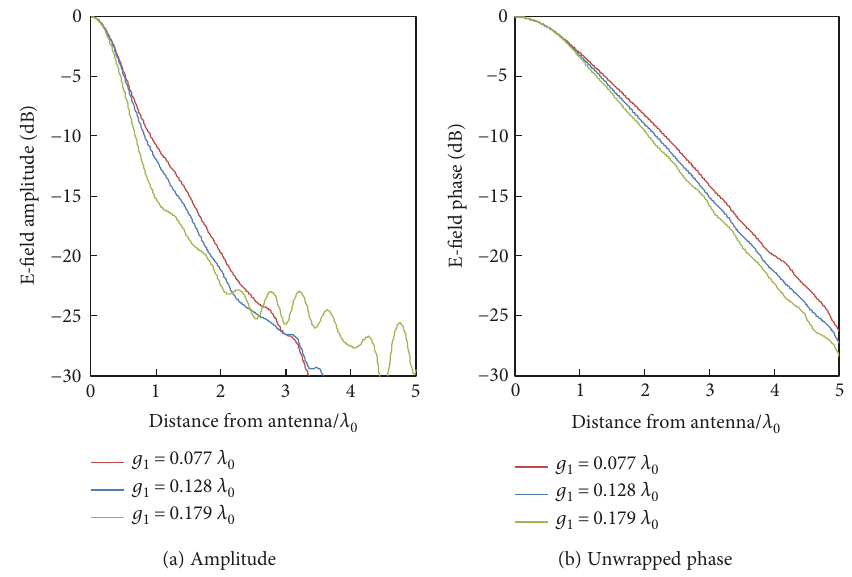
Figure 10: Normalized e- fi eld intensity distribution for the di ff erent ridge widths.